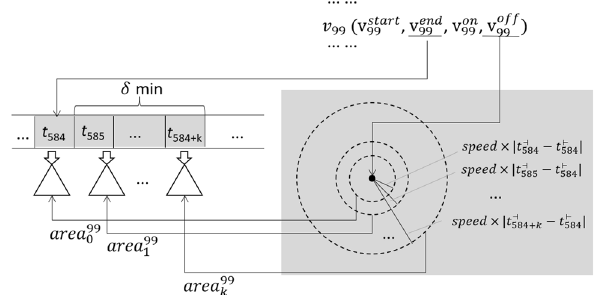
Fig. 9 Distance-based search